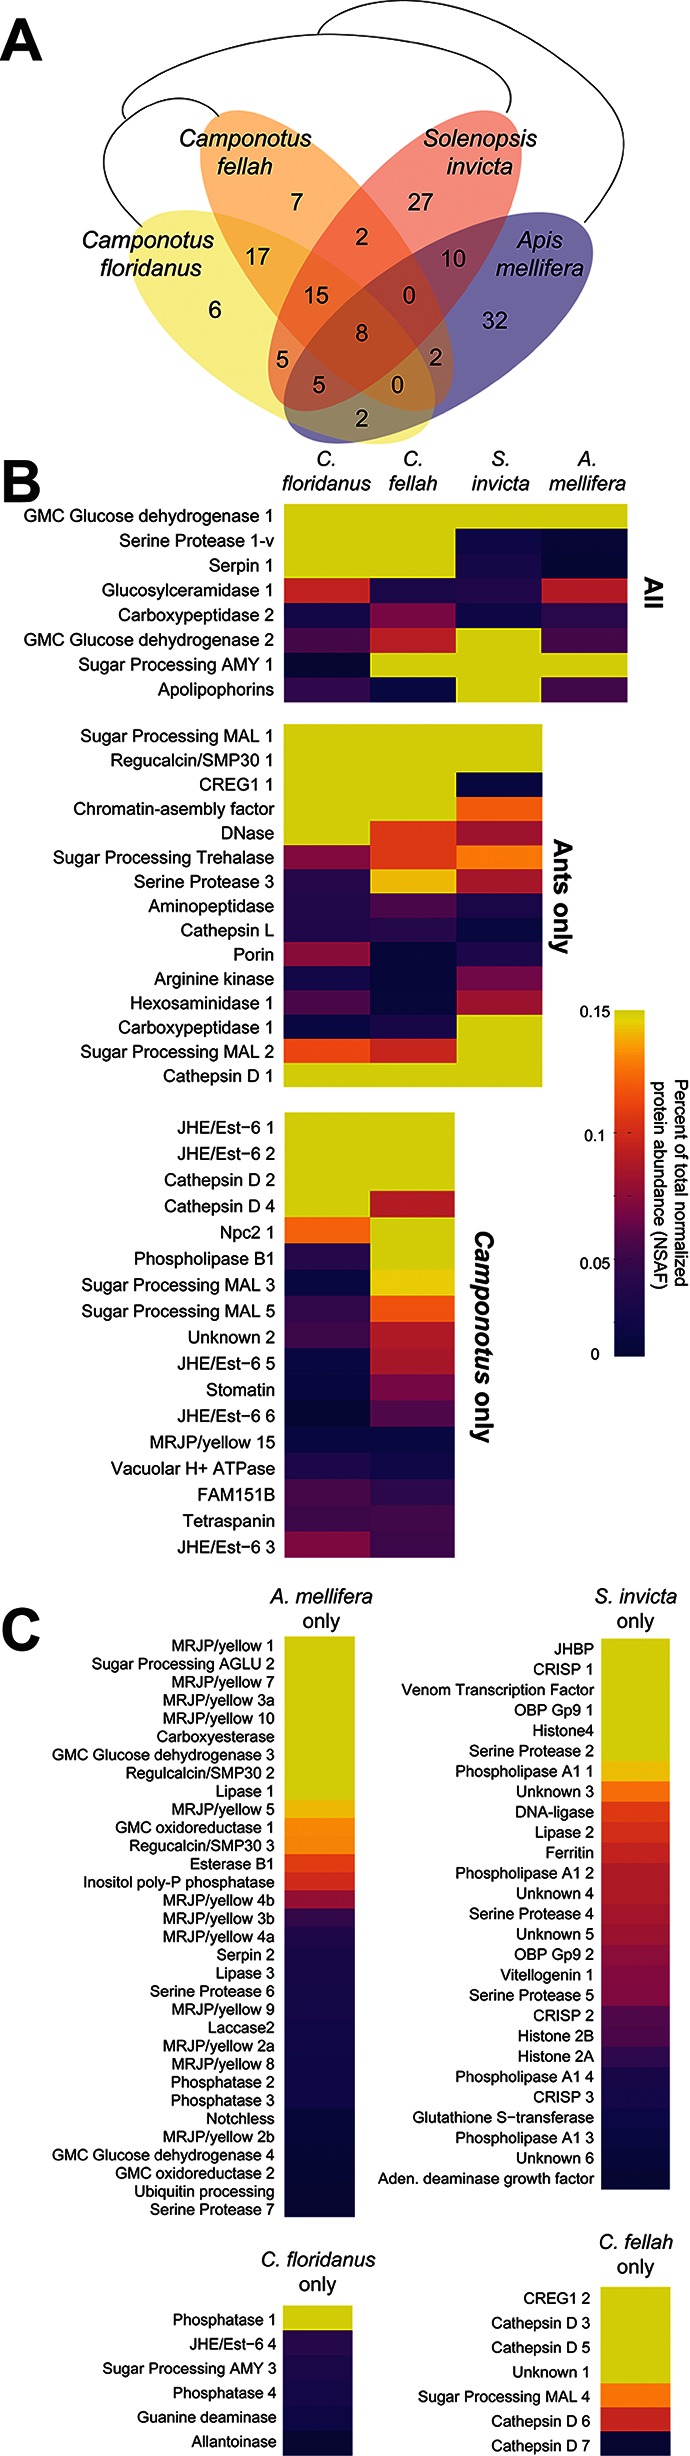
Proteins in trophallactic fluid across social insect species.(A) Venn diagram indicating the number of species-specific and orthologous proteins detected in TF from the indicated species, whose phylogenetic relationships are shown with black lines. (B) Heat maps showing the percentage of total molecular-weight normalized spectra in TF samples assigned to the proteins in each given species, averaged over all in-colony samples for that species. Samples sizes: C. floridanus (n = 15), C. fellah (n = 6), S. invicta (n = 3), A. mellifera (n = 6). (C) Species-specific TF proteins. The 26 TF ortholog groups found in two or three species, but not the most closely related ones (e.g., A. mellifera and S. invicta, or S. invicta and only one of the two Camponotus species) are indicated in Figure 5—figure supplement 1.10.7554/eLife.20375.018Figure 5—source data 1.A table of all orthologous proteins and their predicted functions, identifiers, known D. melanogaster orthologs, presence of annotated secretion signals and average NSAF values when present in TF.A complete orthology across the four species can be found in Supplementary file 3.